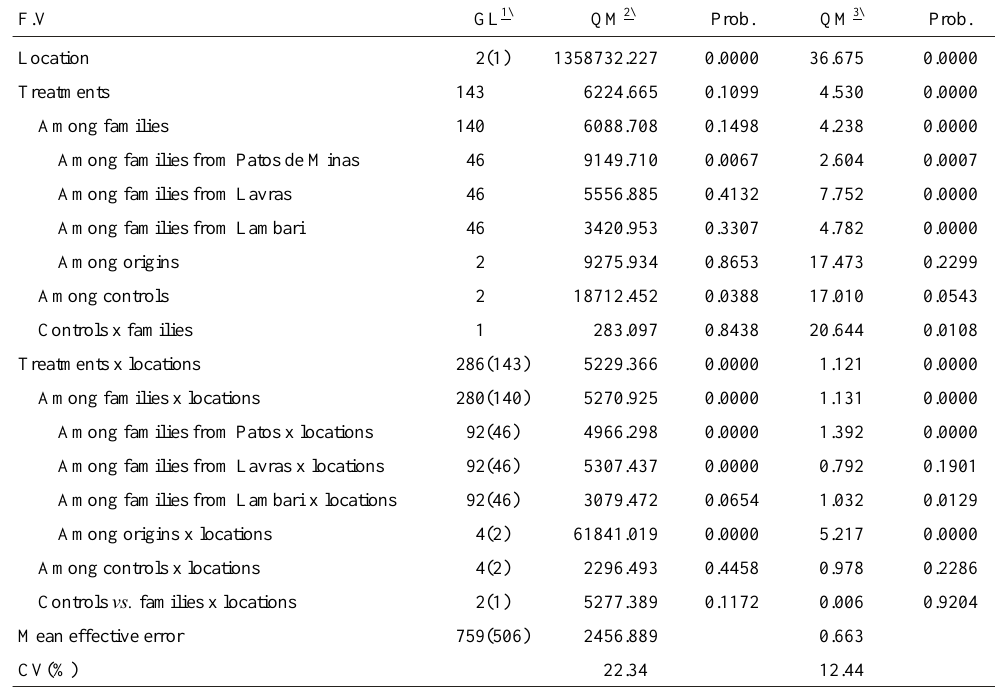
Table I - Sum mary of the grain yield (g/plot) joint anal y ses of vari ance of the F 14:16 fam i lies from the ESAL 686 x Cari oca MG cross as sessed in Lavras, Lambari and Patos de Minas and an gu lar spot se ver ity (scores 1 to 9) in Lavras and Lambari in the wet sea son of 1998/99. F.V GL 1\ QM 2\ Prob.